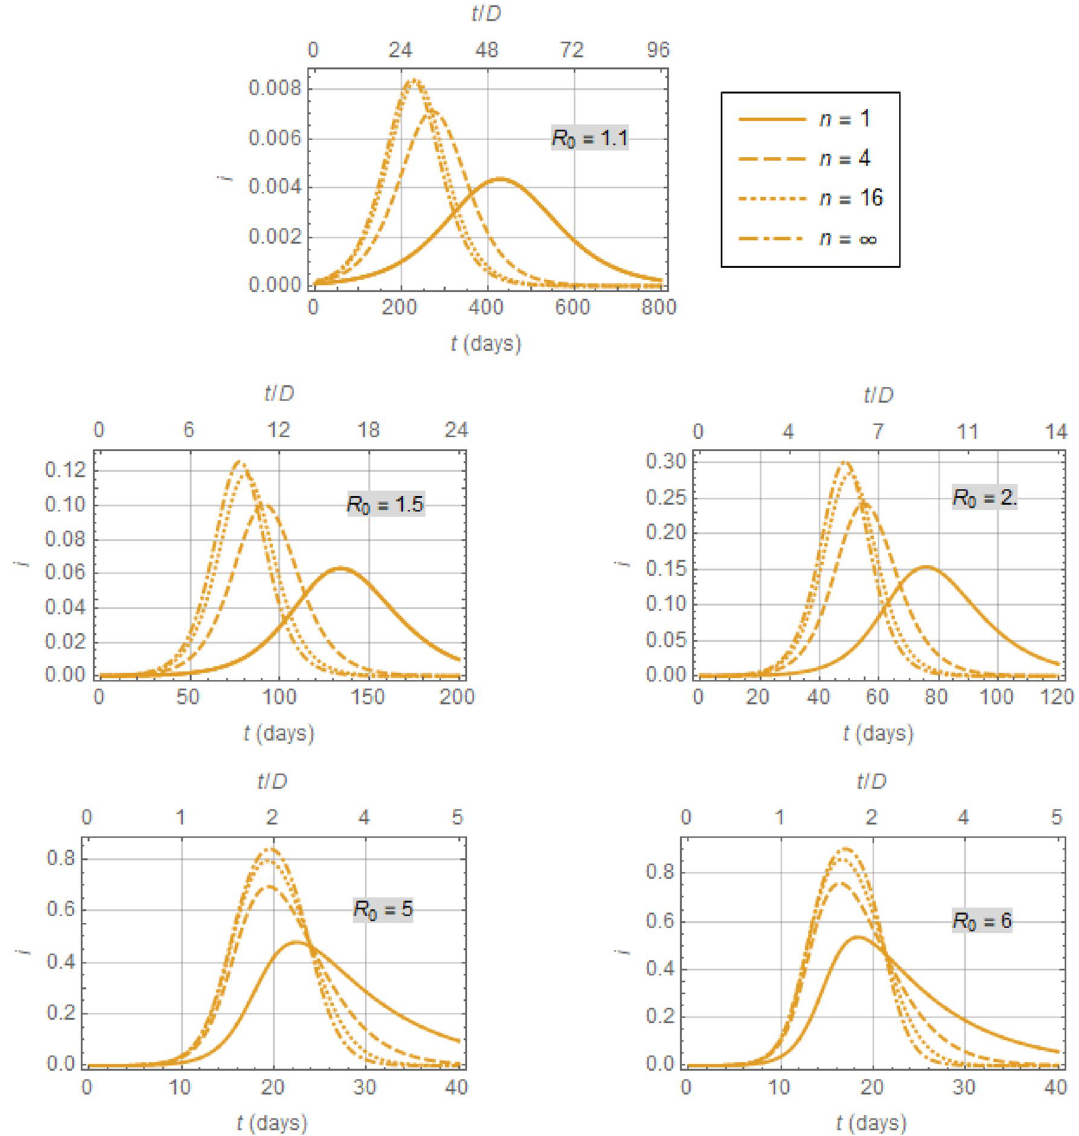
Figure 4. Response of the infectious fraction, i ( t ) , according to the model of Eqs. (1), (4), and (7), for 4 is closer to the exponential distribution distributions shown in Fig. 3. Note that the distribution for n = ) in Fig. 3, yet the response of i ( t ) for n ( n 4 is a lot closer to the 1 ) than to the impulse distribution ( n = = = ∞ response for n rather than to that for n = ∞ =